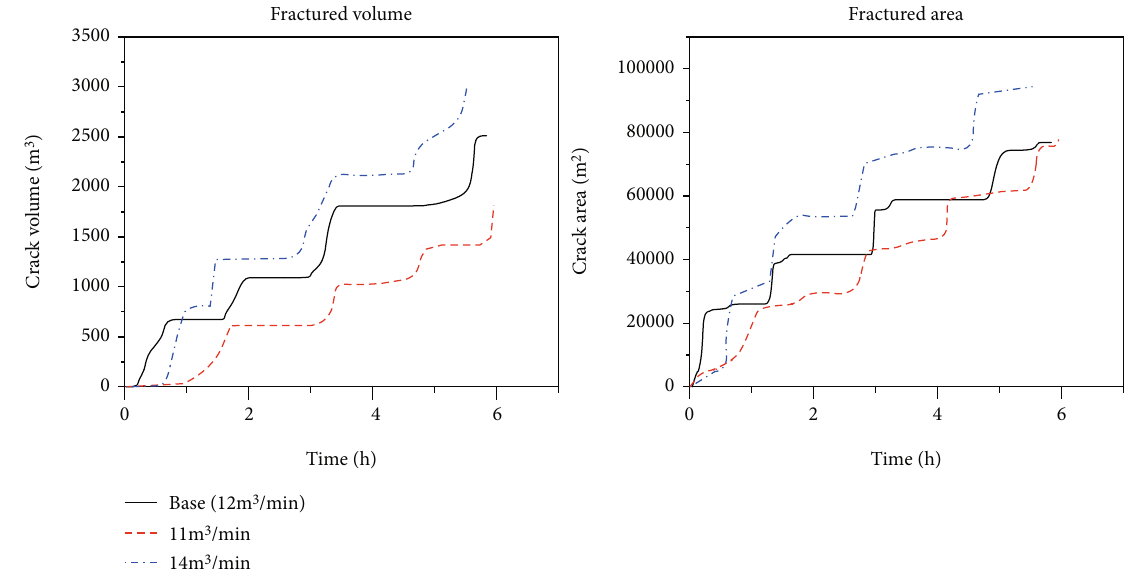
Figure 9: Evolutions of fractured volume and area for scenarios with di ff erent fracturing fl uid injection rates per stage.